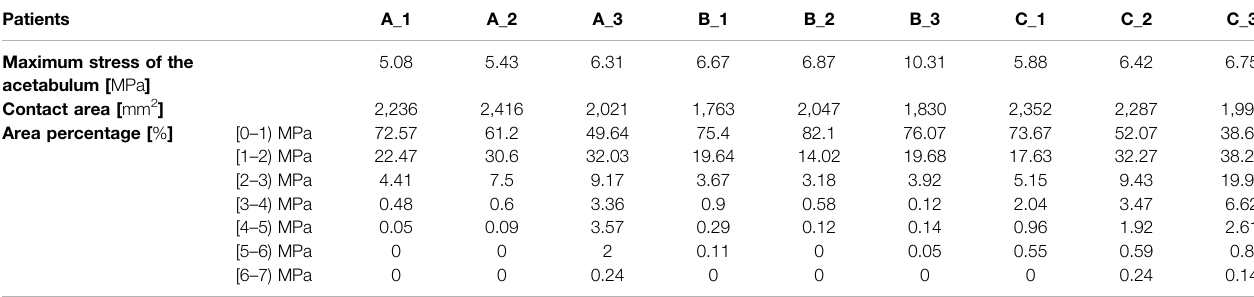
TABLE 3 | Quantitative stress analysis on acetabulum and local facies lunata.